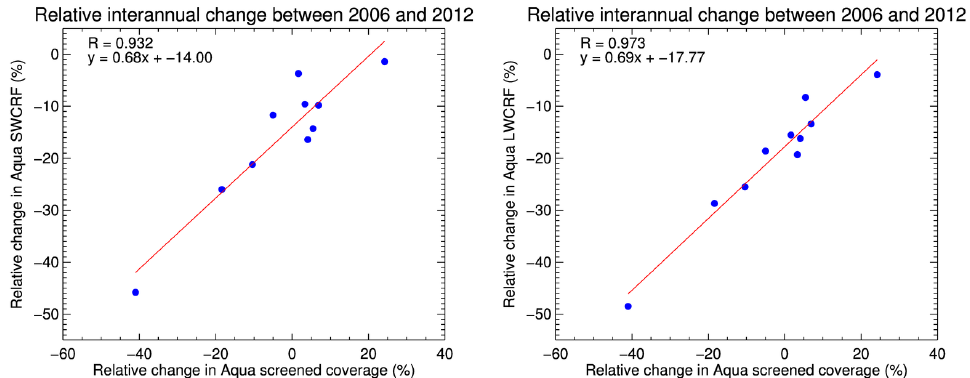
Figure 13. Relative change ((2012–2006)/2006 × 100%) in the total Aqua contrail SWCRF and LWCRF for NH and nine air traffic regions as a function of the relative change in screened CC (day + night, Mask